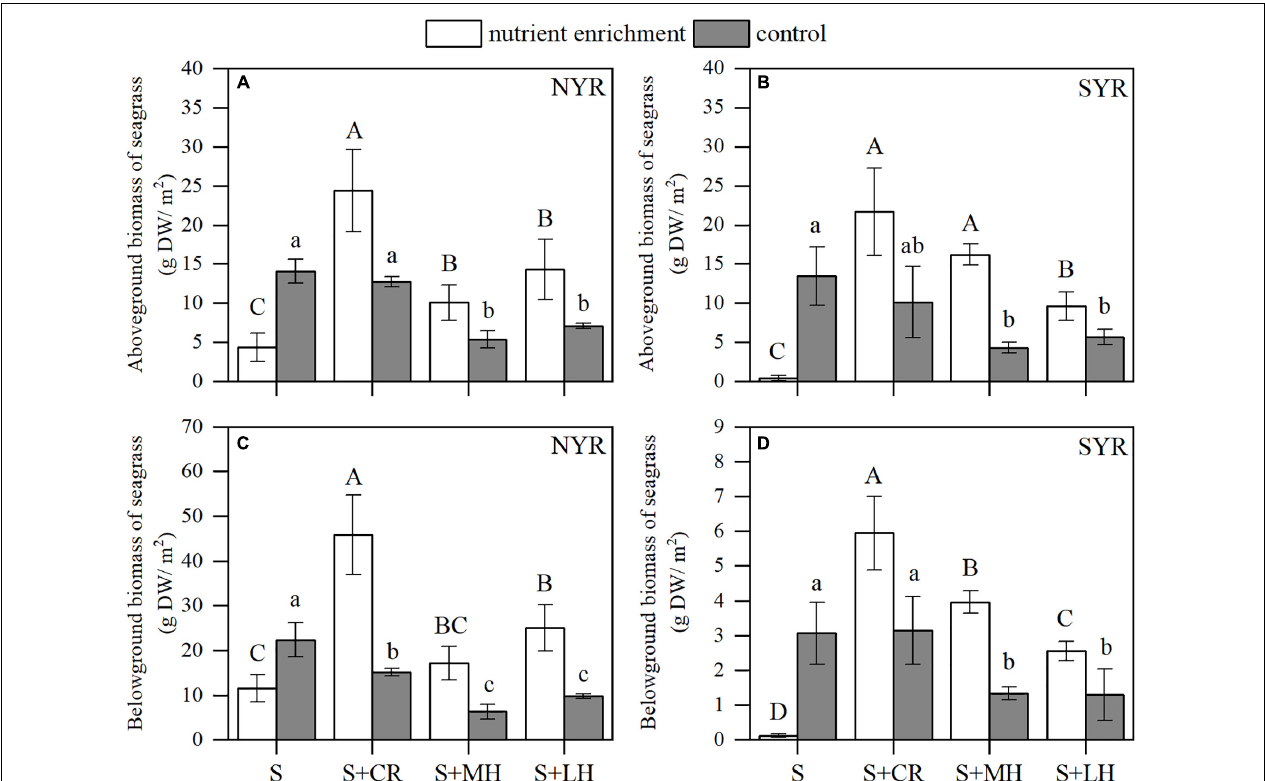
FIGURE 3 | Effects of nutrient enrichment and herbivory on seagrass biomass in the NYR and SYR (mean ± SE , n = 4). (A) Aboveground biomass of seagrass in the NYR; (B) aboveground biomass of seagrass in the SYR; (C) belowground biomass of seagrass in the NYR; (D) belowground biomass of seagrass in the SYR. Within nutrient treatments (enrichment or control), bars sharing a letter are not significantly different from one another ( p >